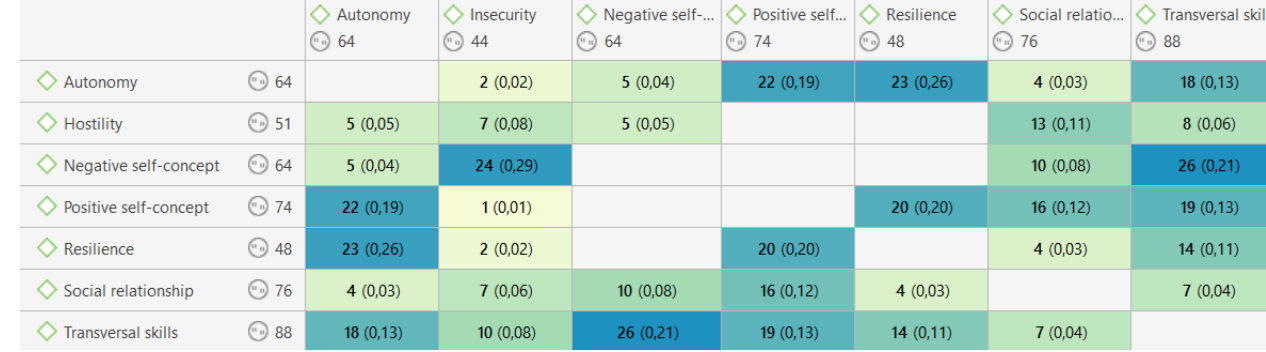
Figure 5. Semantic network with the main relationships between codes. In the first place, the students’ self-concept is pointed out as the main codes that articulate the rest, since, apart from being some of those that appear with greater recurrence, they have a greater density of relationship with other codes. Specifically, when speaking of a negative self-concept, it is observed that it is directly related to transversal skills with a co-occurrence of @ 0.21, which are necessary for them in their day-to-day life and facilitate their inclusion and participation in society (Rocco 2011) (“I’m not good with technology, I don’t know how to handle e-mail nor some programs I don’t know how to use” (1:230)) and the insecurity (@ 0.29) that they present, in general, because of those skills that they must develop to perform basic tasks when attending university (Brewer and Movahedazarhouligh 2019), as someone said “I get overwhelmed when I don’t know how to do something like send e-mails”(1:229). On the other hand, there are some highlights when talking about their positive self- concept: their ability to be resilient (@ 0.20) (“I am capable of overcoming my fears” (1:79)) and the will they express to be autonomous and their capacity they have to do so (@ 0.19) (“I have been able to make my own decisions. I changed my professional profile” (1:52)), emphasizing the association established with that presence of resilience that characterizes them. A capacity to overcome adversity has already been reflected on other occasions (Moriña et al. 2020b) and that stands out in studies where subjects with and without disabilities are compared (Vehmas and Watson 2014). Besides, a contradiction arises between the different perceptions of themselves, when speaking of transversal skills, since they also express it as a potentiality (“I am good at mechanical work (Leroy Merlin)” (1: